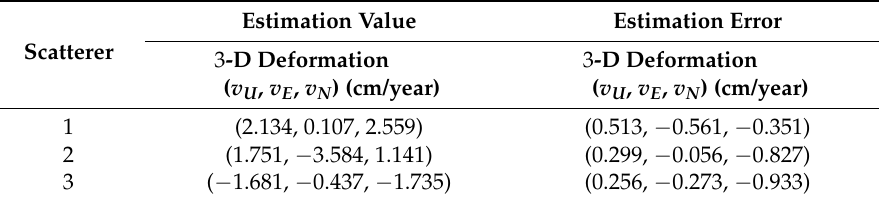
North-South, and Up-Down